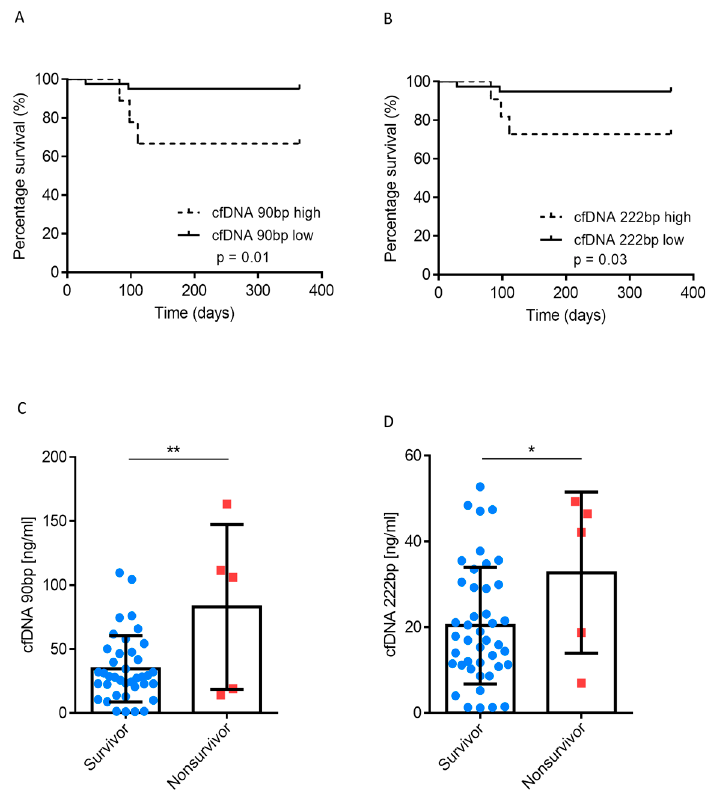
Figure 2. ( A , B ) cfDNA analysed according to survivors and non-survivors (1-year follow-up) ( C , D ). Patients analysed according to 1-year survival in high and low cfDNA groups. Mann–Whitney U test; Log-rank test (for survival); * p < 0.05; ** p < 0.01.